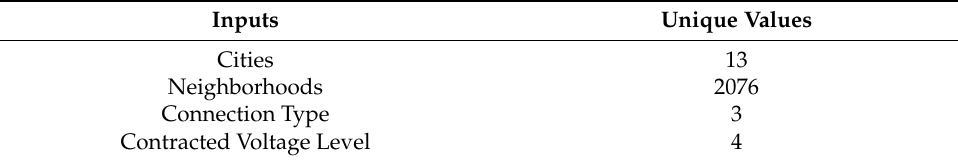
Table 8. Inspected Consumer Units Labeled as NTL.